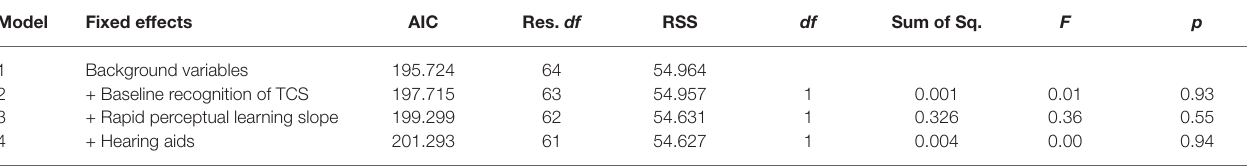
TABLE 8 | Dichotic sum—results of the comparison of nested model tests. Model